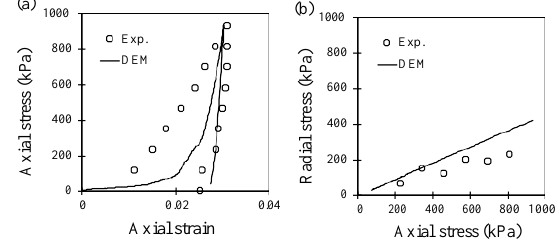
Fig. 6 . Calibration of DEM parameters.